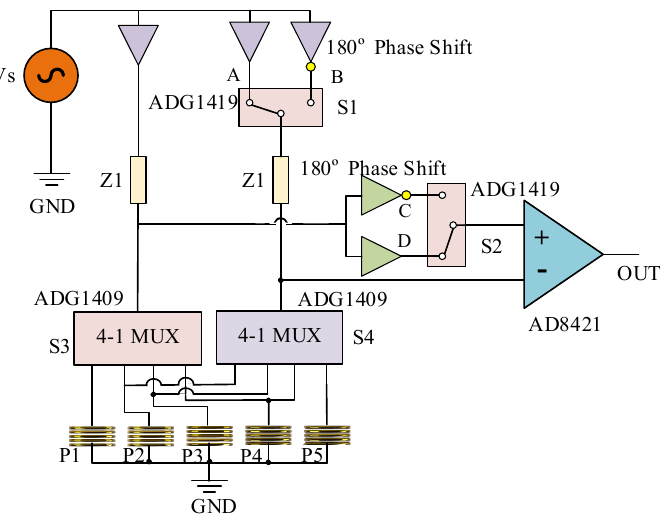
Figure 2. Circuit diagram of the probe for one row of coils. Table 1. Chart of switching the multiplexers.